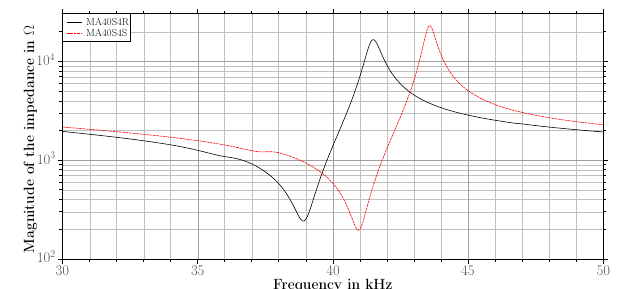
Figure 3. Impedance magnitude of the piezoelectric receiver and sender. The minimum magnitude corresponds to the series reso- nance and the maximum to the parallel resonance. The series reso- nance of the sender is near the parallel resonance of the receiver.